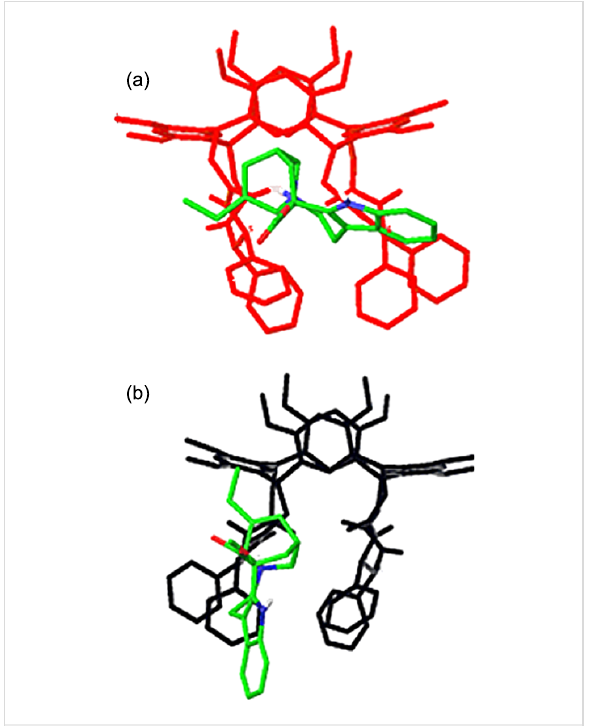
Figure 6: Global minima of (a) [ V S ∙ H ∙ T] + and (b) [ V R ∙ H ∙ T] + complexes.